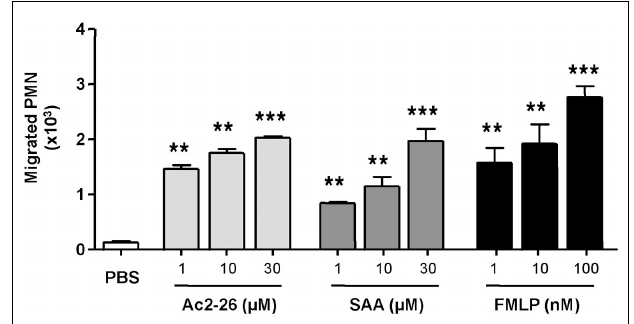
FIGURE 1 | PeptideAc2-26 provokes migration of human PMN: comparison to FMLP and SAA. Neutrophils isolated from peripheral blood of healthy volunteers were resuspended at 4 × 10 6 cells/ml and chemotaxis to peptide Ac2-26 (1–30 μ M), SAA (1–30 μ M), or FMLP (1–100nM) was assessed over a 90-min period. Results are ± SEM from three to four cell preparations (** P < 0.01, *** P < 0.001 vs. PBS